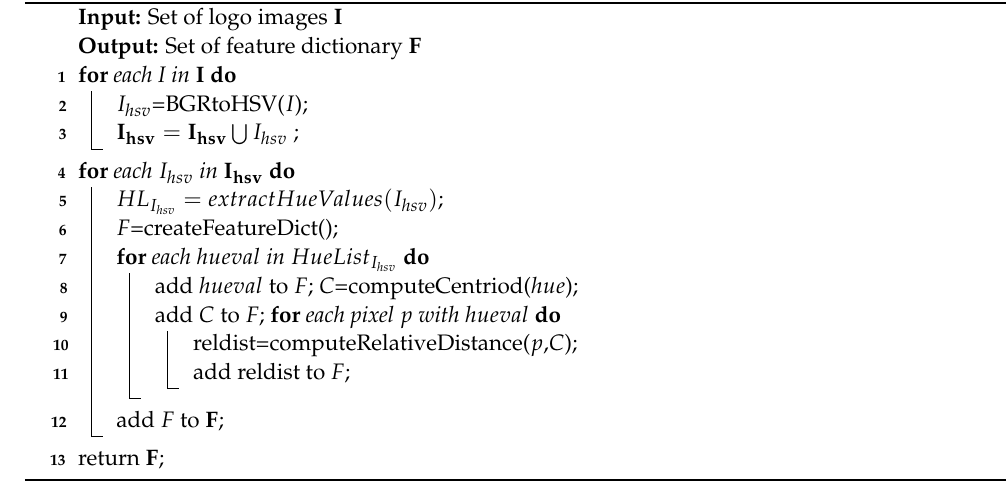
Algorithm 1: The algorithm for logo feature extraction.